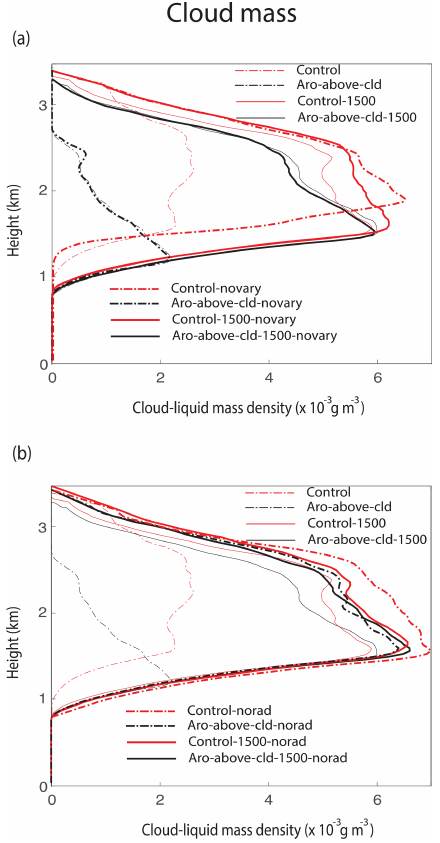
Figure 11. Vertical distributions of the time- and area-averaged cloud liquid mass density. The control-novary, aro-above-cld- novary, control-1500-novary and aro-above-cld-1500-novary runs (a) as well as the control-norad, aro-above-cld-norad, control-1500- norad and aro-above-cld-1500-norad runs (b) are shown together with the standard